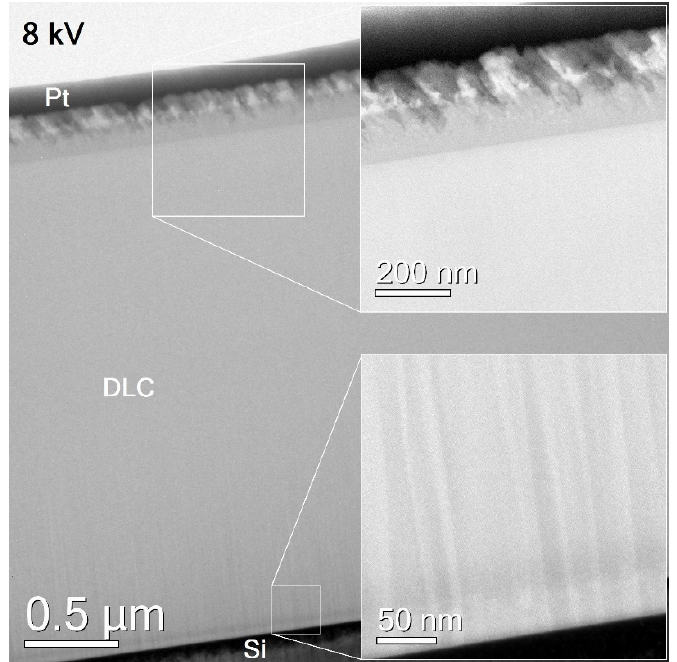
Figure 4. Cross-sectional TEM image of a DLC coating on silicon produced with an acceleration voltage of 8 kV. Insets show magnified regions at the interfaces.